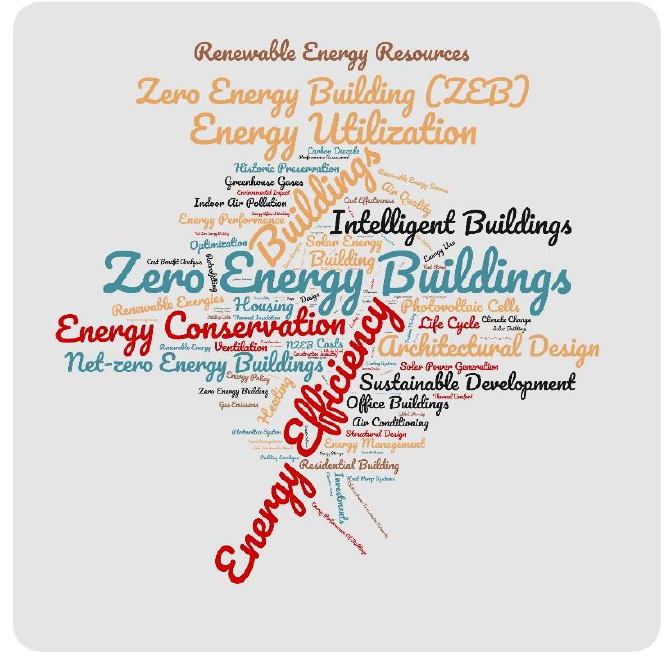
Figure 2. The keywords used globally in the literature according to Scopus [21].